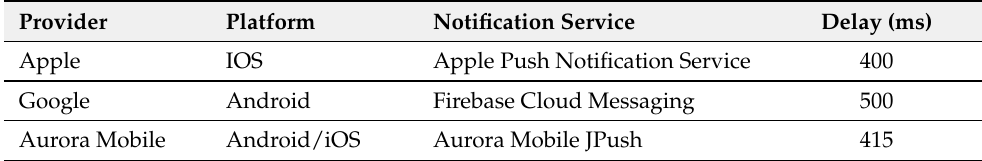
Table 9. Normal Delay of Notification